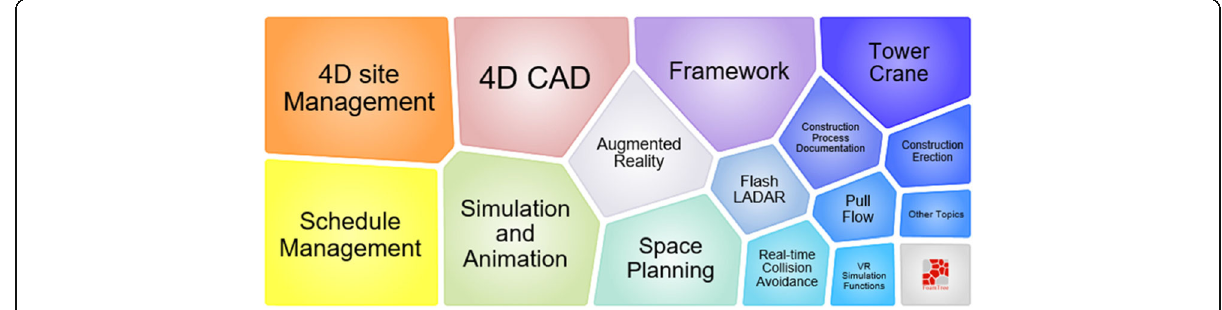
Fig. 9 Foam tree view of keywords in topic